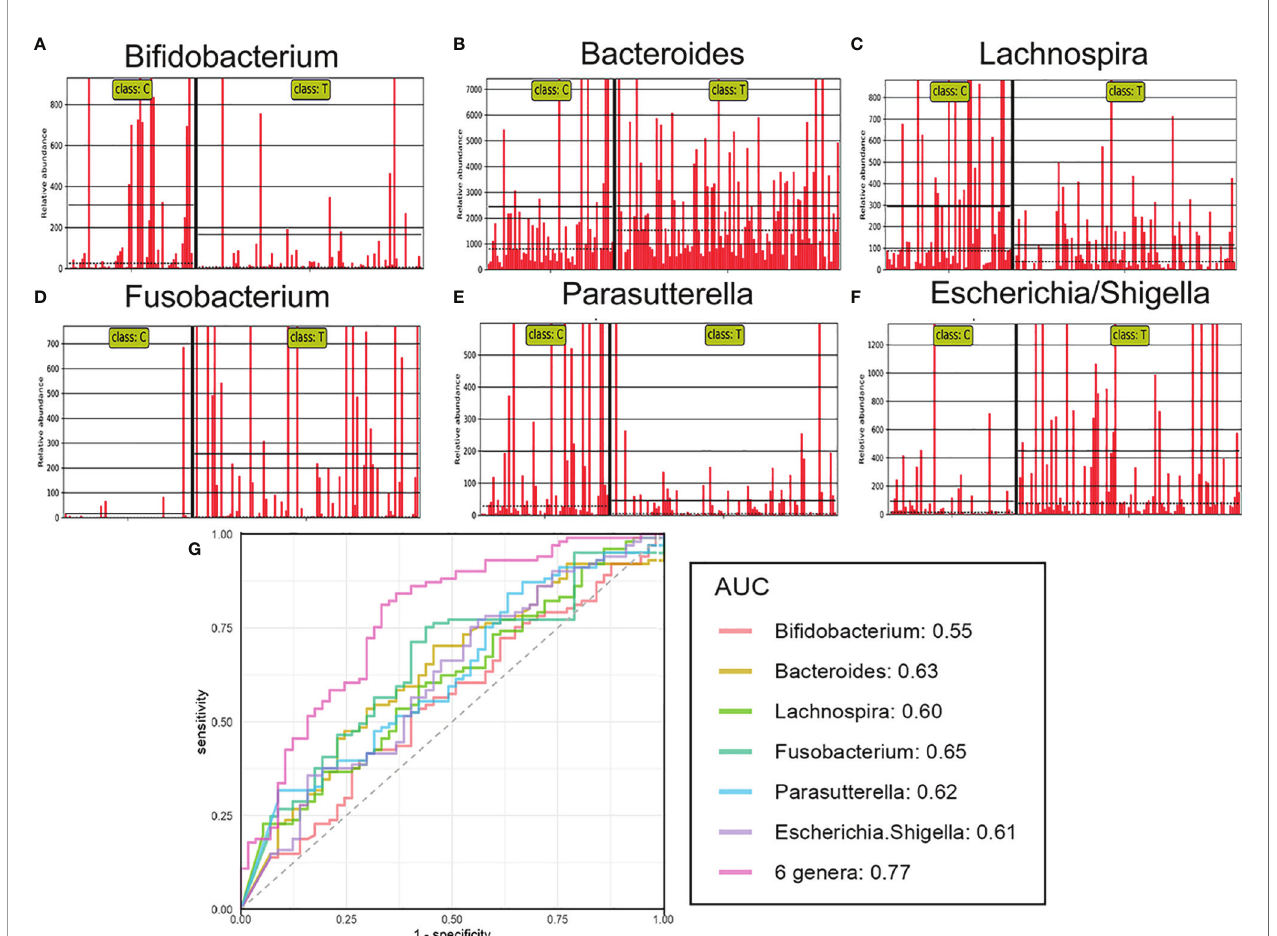
FIGURE 4 | The relative abundance and predictive ability for brain tumours of differential genera. The relative abundance of the differential genera such as Bi fi dobacterium (A) , Bacteroides (B) , Lachnospira (C) , Fusobacterium (D) , Parasutterella (E) , Escherichia/Shigella (F) in each sample. Receiver operating characteristic (ROC) curves for the differential genera alone or in combination (G) , which was calculated to discriminate brain tumor patients from healthy controls. AUC: the area under the receiver operating characteristic